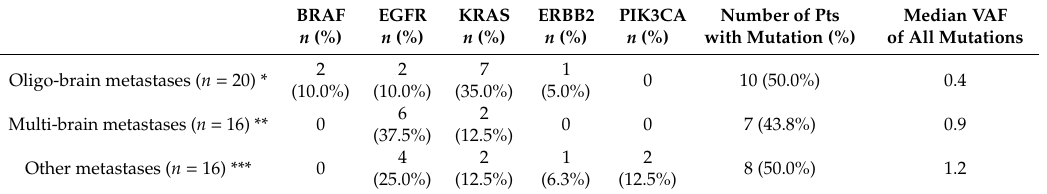
Table 2. Prevalence of detected mutations in circulating tumor DNA (ctDNA)